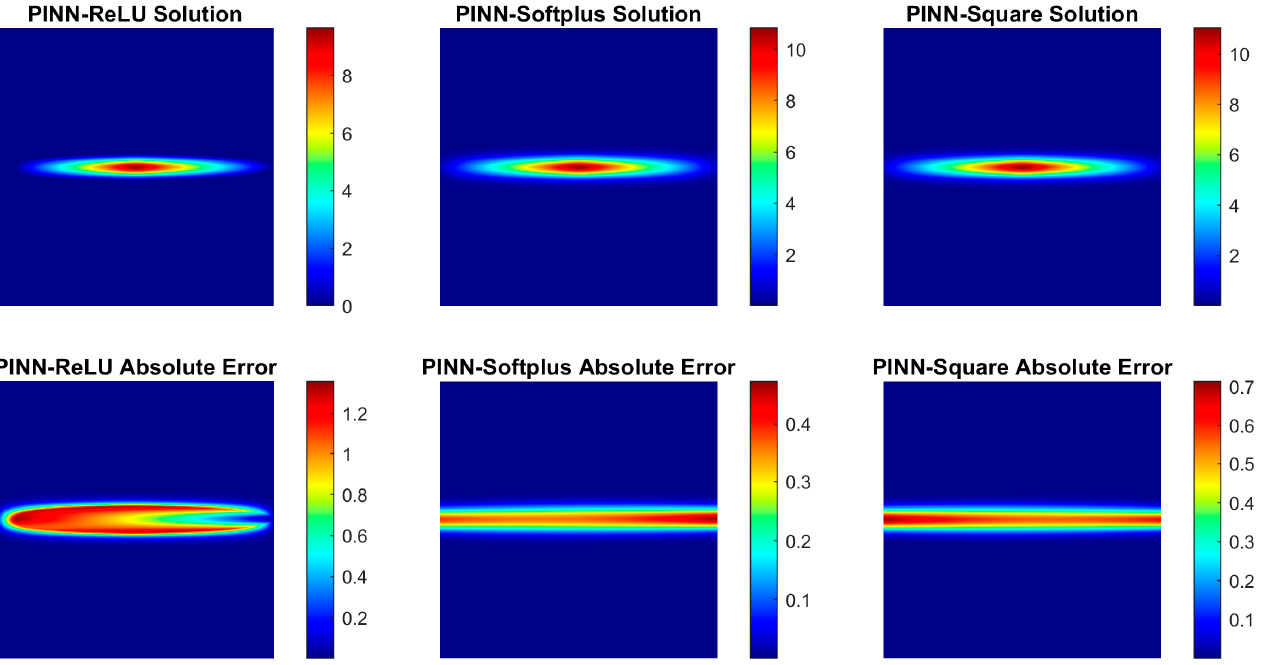
Figure 7. Solution results of the three PINN models that are positivity-preserving.